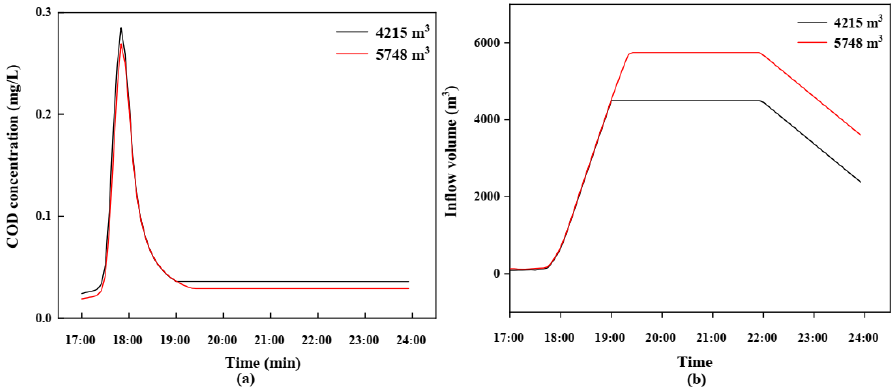
Figure 7. The optimization of storage tank volume: ( a ) The simulation of different storage tank volume on COD interception rate; ( b ) The simulation of different storage tank